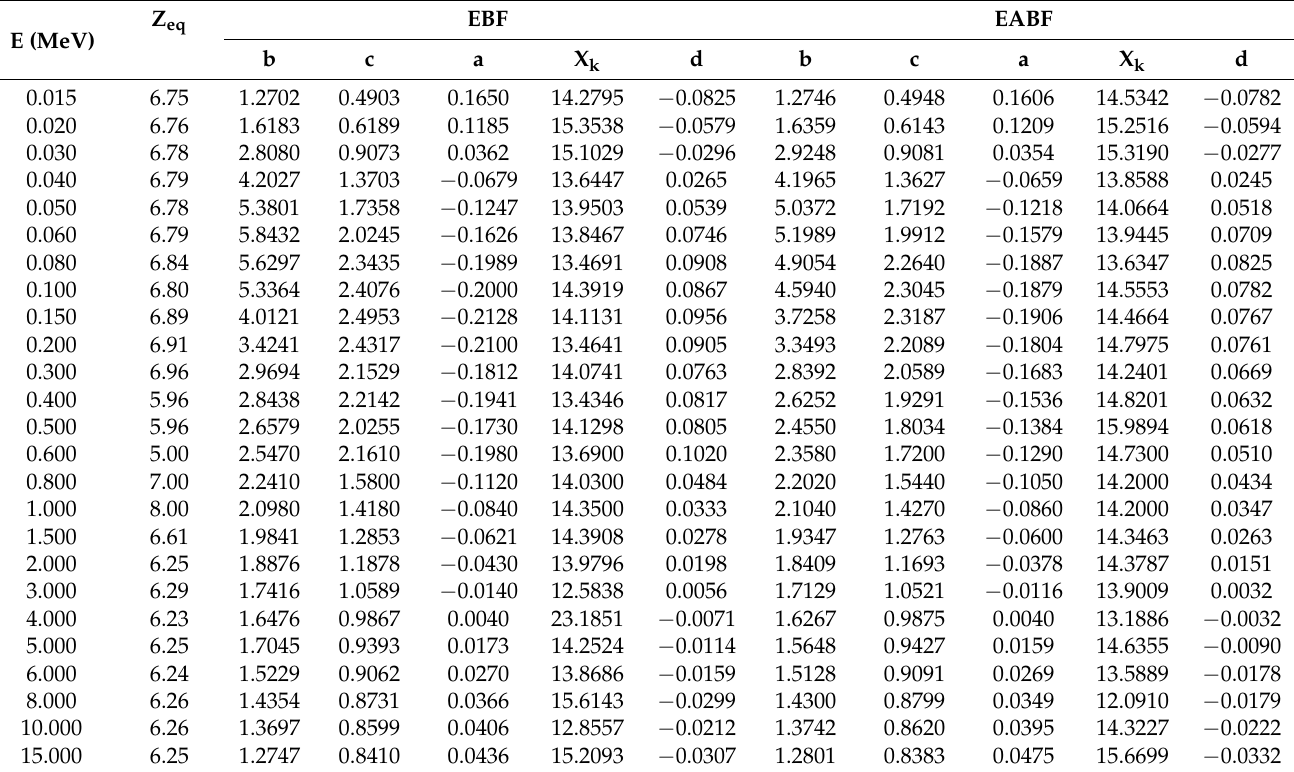
Table 3. (EBF and EABF) G-P fitting coefficients (b. c. a. X k and d) of CuZn00 sample.